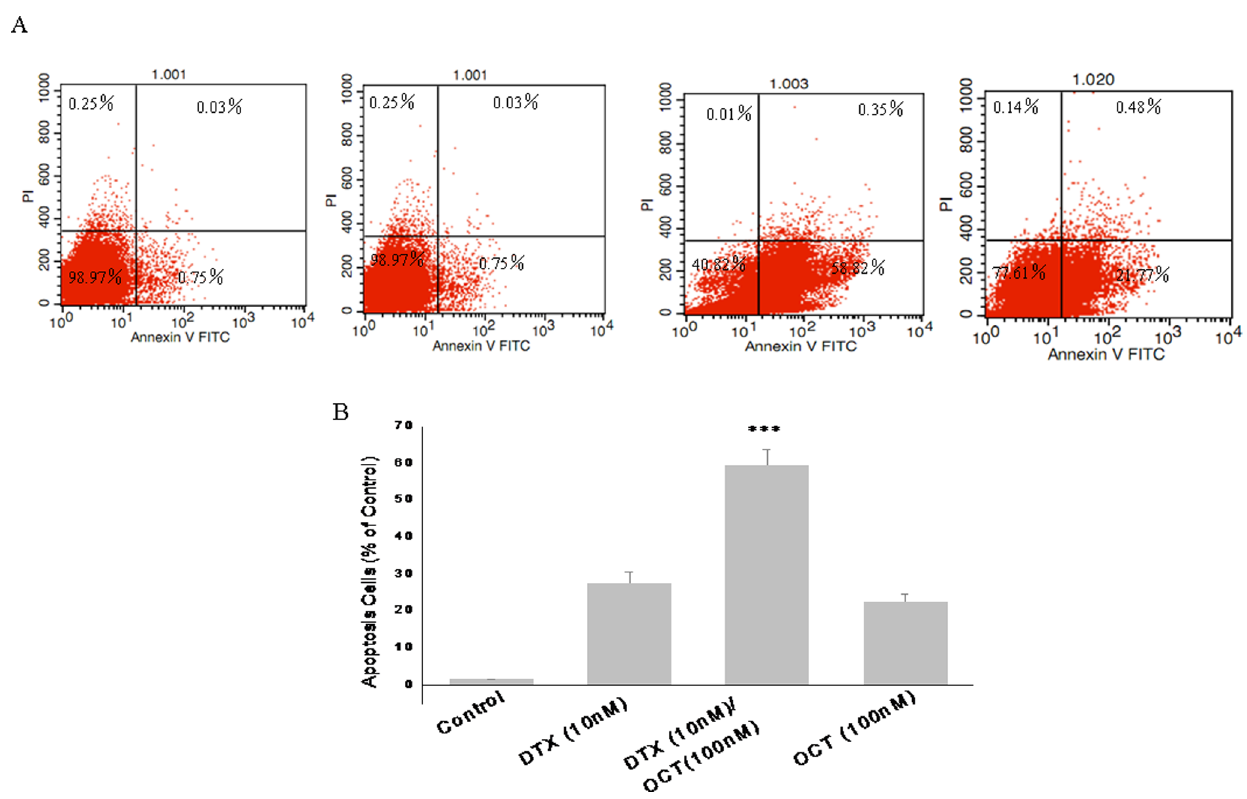
Figure 5. Effect of DTX, OCT alone and two-drug combination treatment on DU145 cells apoptosis. Data are mean 6 SEM of two independent experiments performed in triplicate. *** p , 0.000 vs. control.